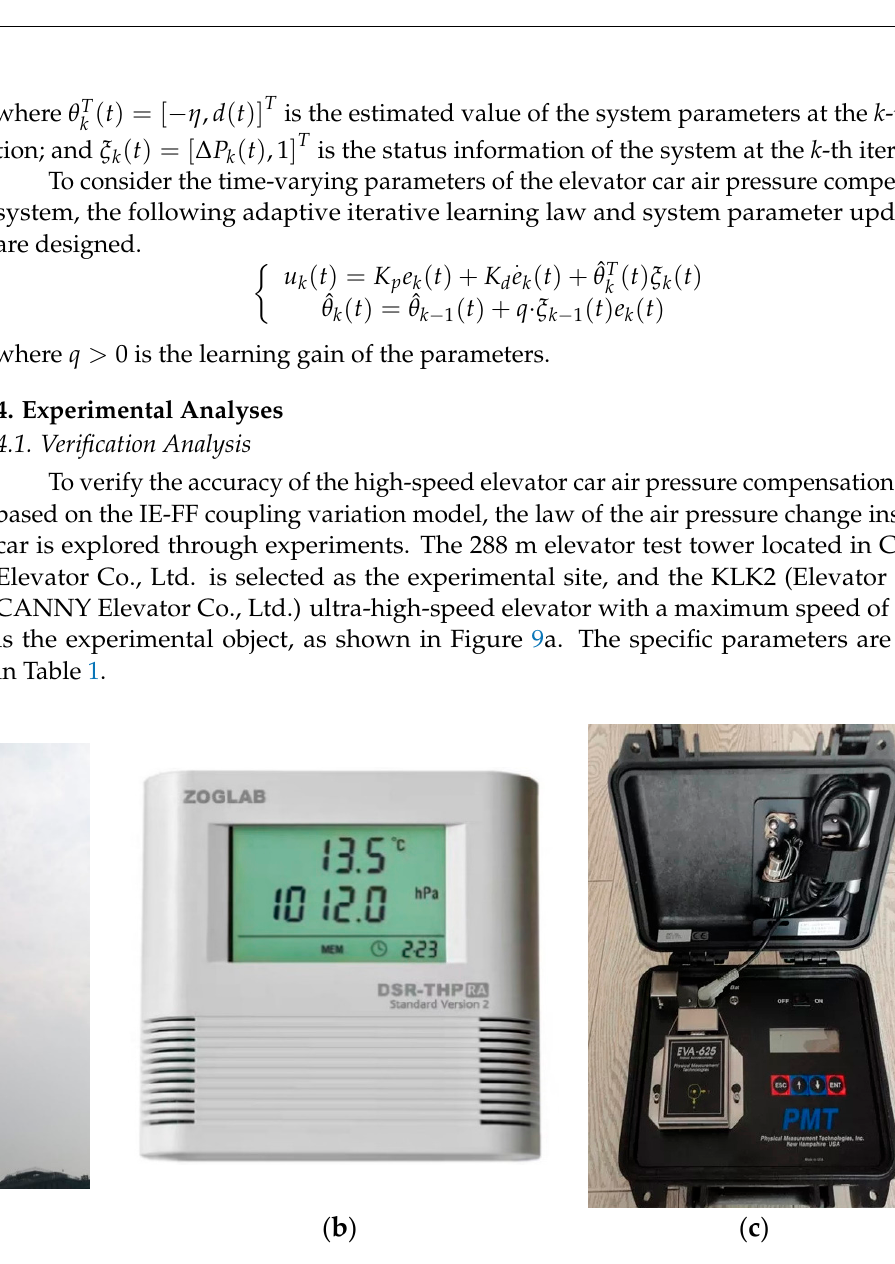
Figure 9. Experimental instruments. ( a ) 288 m elevator test tower in Canny; ( b ) ZOGLAB DSR ‐ THP temperature, humidity and pressure recorder; and ( c ) PMT ‐ EVA625 elevator comprehensive performance tester. Table 1. Parameters of the KLK2 ultra-high-speed